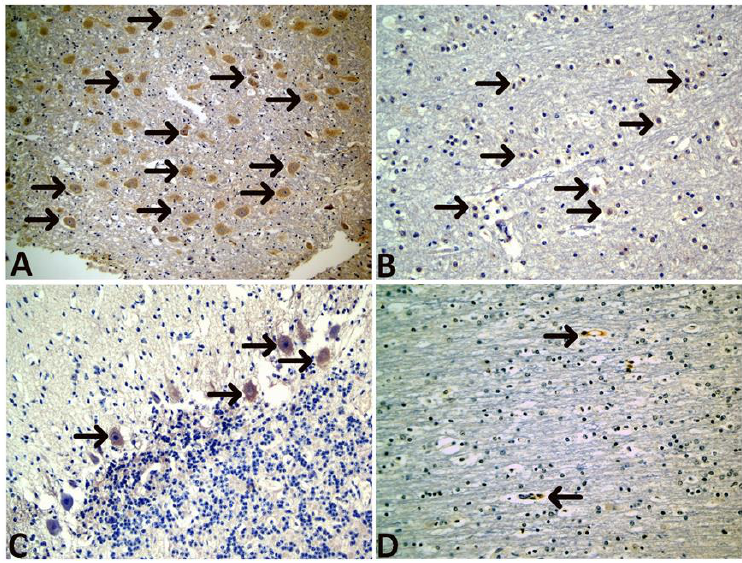
Figure 5. Immunohistochemical findings. ( A ) Immune positive reaction in neurons (arrows), HIF-1 α , 20 × , ( B ) Immune positive reaction in glia cells (arrows), HIF-1 α , 20 × , ( C ) Immune positive reaction in Purkinje cells (arrows), HIF-1 α , 40 × , ( D ) Vascular Immunopositivity in endothelial cells and their walls, (arrows), HIF-1 α , 20 ×